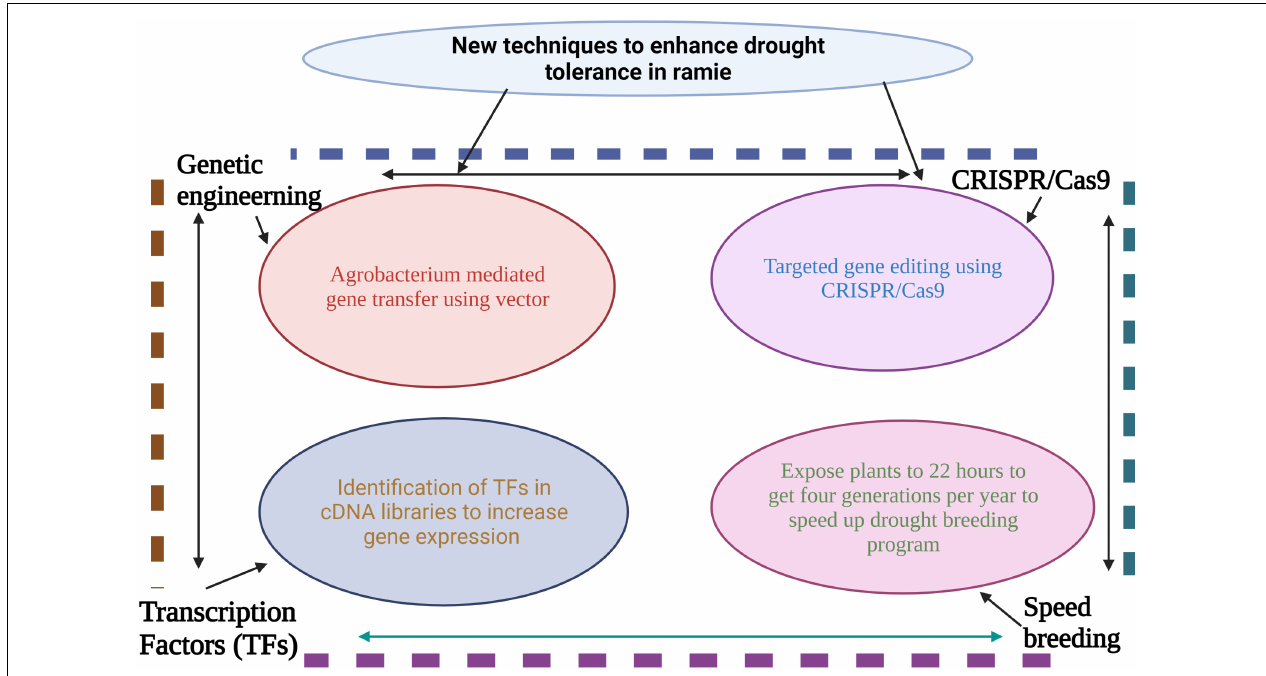
FIGURE 5 | Use of several techniques to develop drought resilient ramie cultivars. Genetic engineering technique is used for gene transfer using Agrobacterium vector. CRISPR/Cas9 and transcriptome techniques can be widely used for enhancement of drought tolerance in ramie. Speed breeding can also be used for reduce the time period for development of tolerance ramie